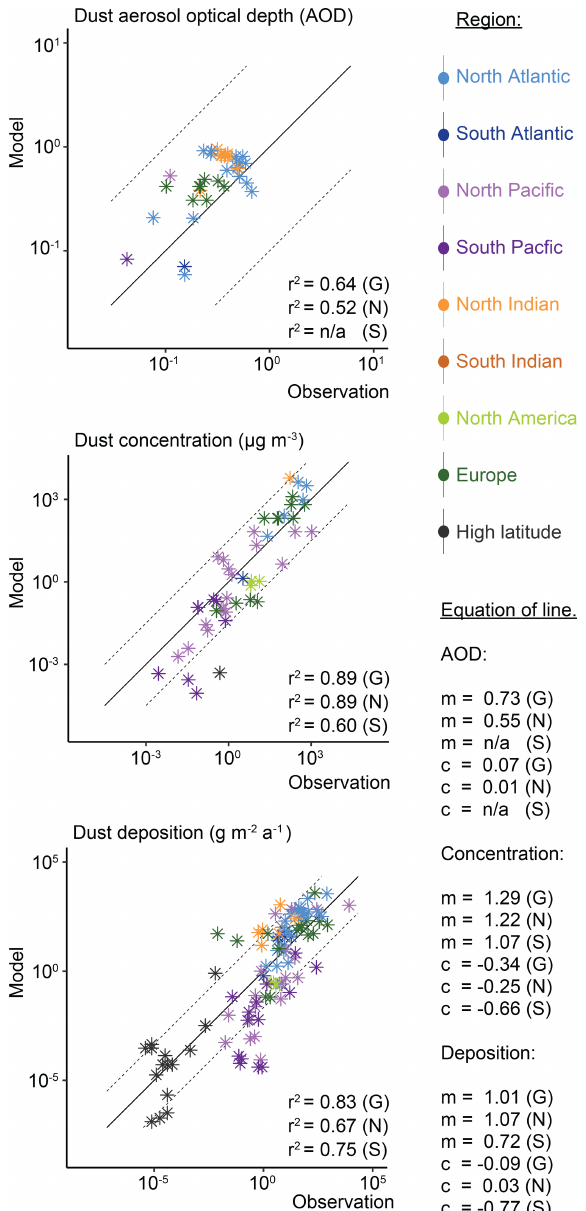
Figure 2. Dust aerosol optical depth, surface concentrations, and deposition in modal aerosol model and observations (Albani et al., 2014; Holben et al., 1998). Correlation ( r 2 ), gradient (m), and inter- cept (c) shown for global (G), Northern Hemisphere (N), and South- ern Hemisphere (S) regions.